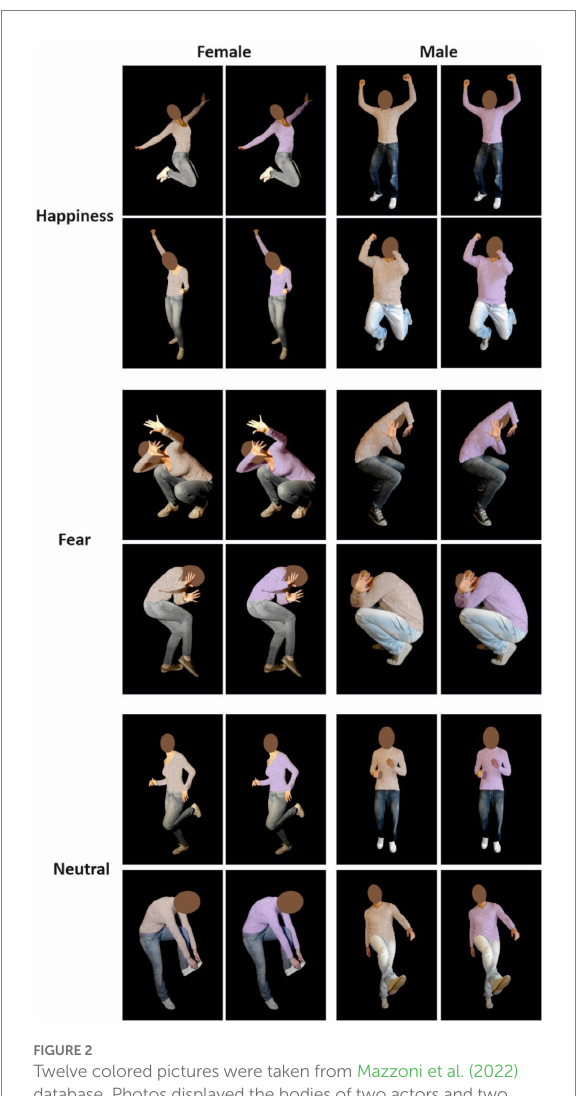
FIGURE 2 Twelve colored pictures were taken from Mazzoni et al. (2022) database. Photos displayed the bodies of two actors and two actresses with blurred faces on a black background. They enacted emotional postures (i.e., fear and happiness) or neutral. Neutral stimuli were dynamic body postures in which actors/ actresses were performing actions without emotional connotations, such as running, kicking, or wearing a sock. Thus, our final set of stimuli was composed of 24